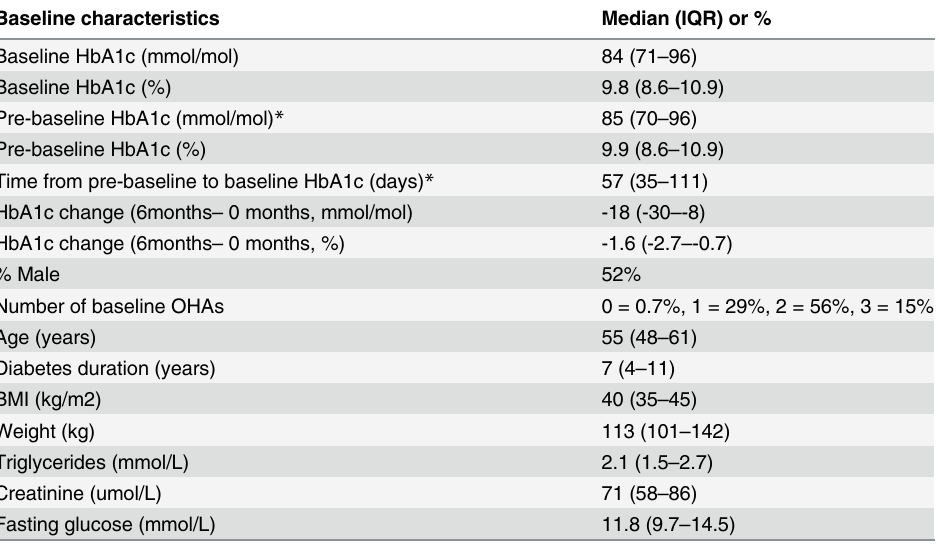
Table 1. Participants baseline characteristics (GLP-1RA cohort, n =